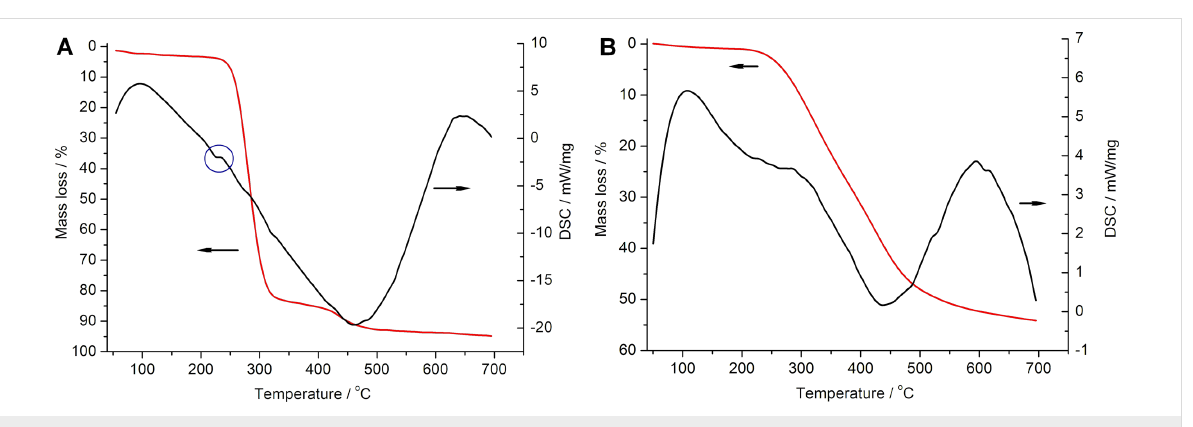
Figure 2: TG-DSC curves of the linear (A) and cross-linked (B) PVA in